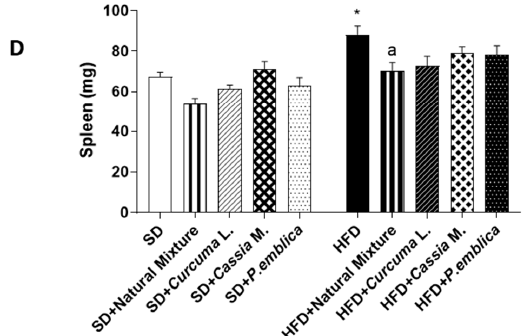
Figure 1. Effects of natural mixture, Curcuma L., Cassia M. and P. emblica on body weight ( A ), BMI ( B ), liver weight ( C ) and spleen weight ( D ) in HFD- and SD-fed mice. Each column shows the mean ± SEM ( n = 10). Two-way and one-way ANOVA, and Tukey post hoc test results are as follows: *— p < 0.05 for significant difference vs. the SD group, and a — p < 0.05 for significant difference vs. the HFD group. Abbreviations: BMI—body mass index; HFD—high fat diet; SD—standard diet.